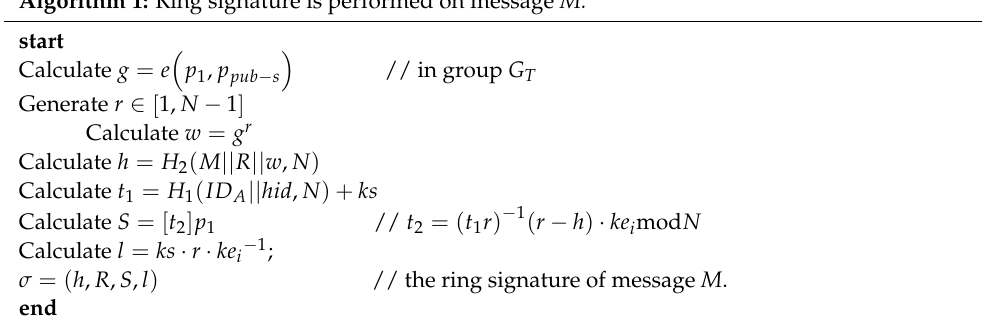
Algorithm 1: Ring signature is performed on message M.